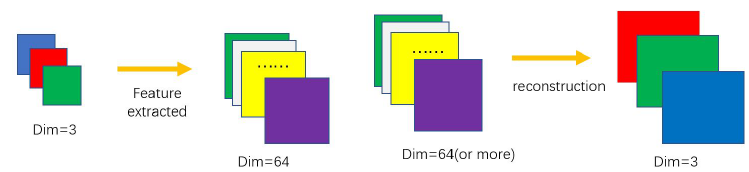
Figure 9. Two parts’ operations in